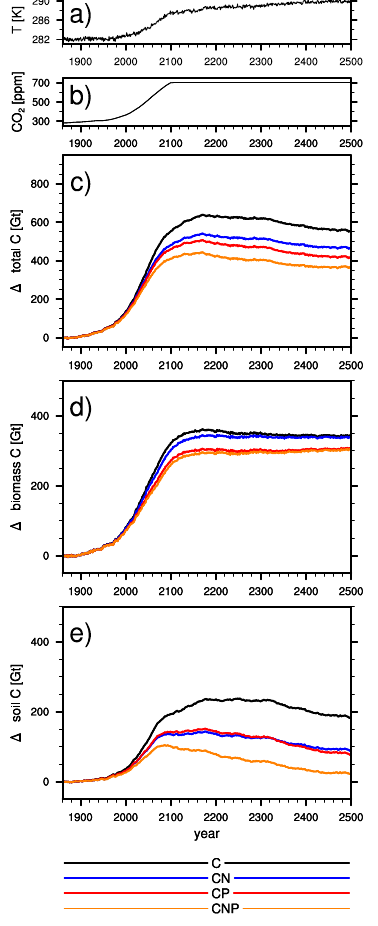
Fig. 3. The simulated change in land carbon storage under the SRES A1B scenario. Shown are the 10-yr mean of soil temperature (a) , the CO 2 concentration as used in the forcing simulation (b) , the resulting change in total land C storage (c) , and the changes in the two main land compartments vegetation (d) and soil (e) .